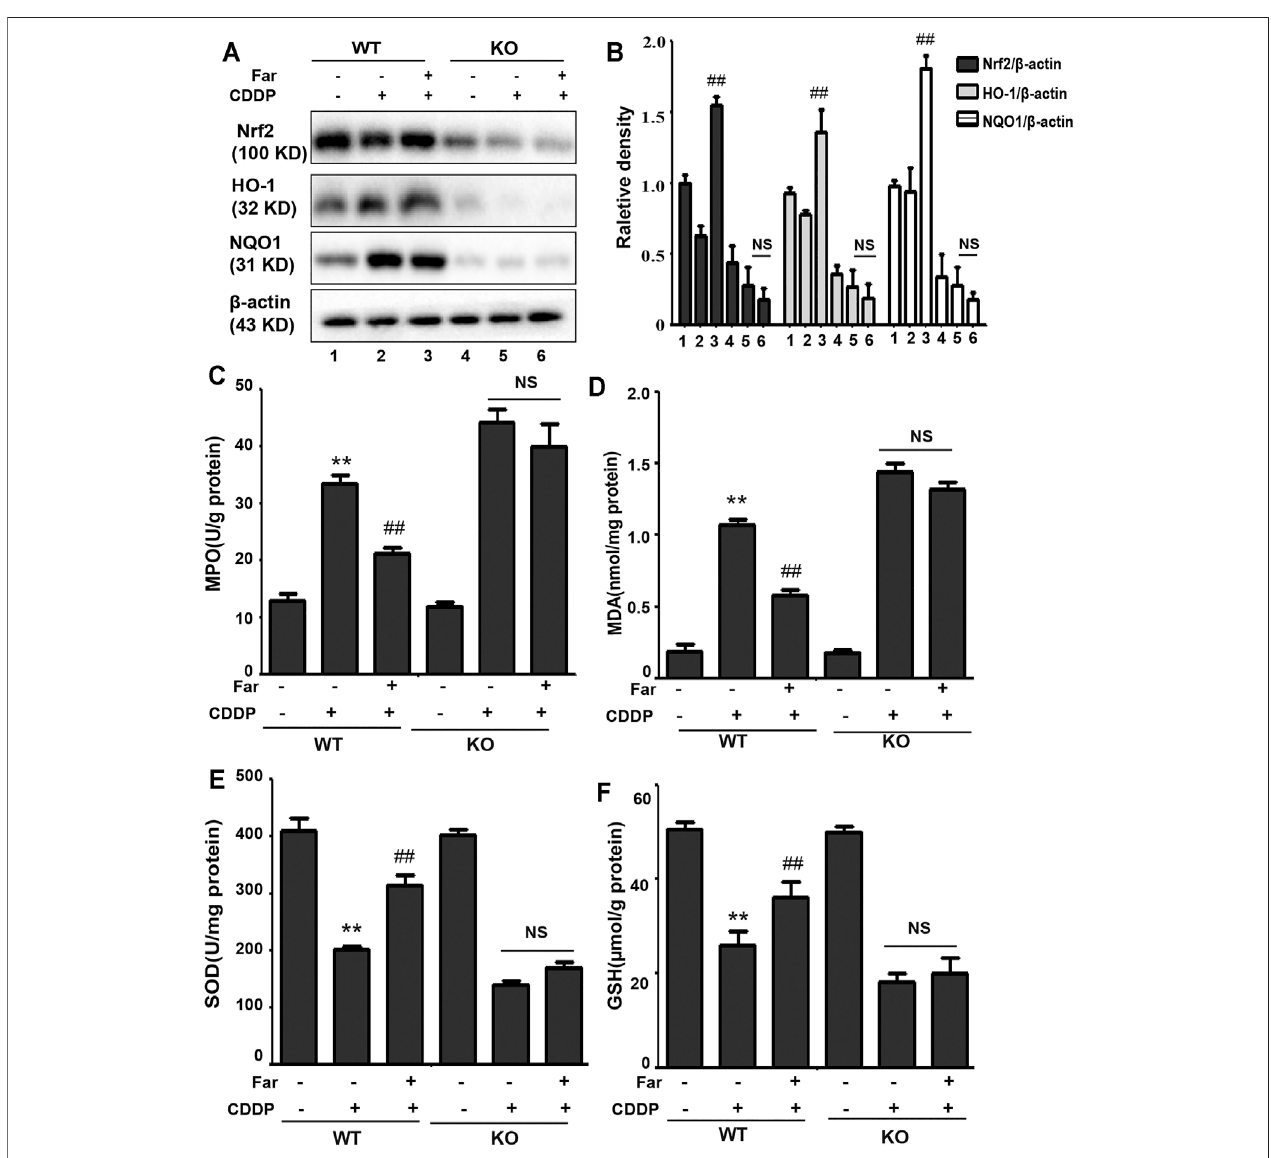
FIGURE7| Nrf2de fi ciencyexacerbatesoxidativestressinCDDP-CKDmousemodels. (A,B) WesternblotanalysisofNrf2,HO-1,andNQO1inwild-typeandNrf2 knockoutmousekidneys. (C – F) TheindicatorsMPO,MDA,SODandGSHwereassessedinkidneytissues.Dataareexpressedasthemean ± SEM( n (cid:1) 6pergroup).All ofthedatadisplayedrepresentthemeanofthreeindependentexperiments.* p < 0.05and** p < 0.01vs.thecontrolgroup; # p < 0.05and ## p < 0.01vs.theCDDPgroup. NS, no speci fi city. β -actin was used as an internal